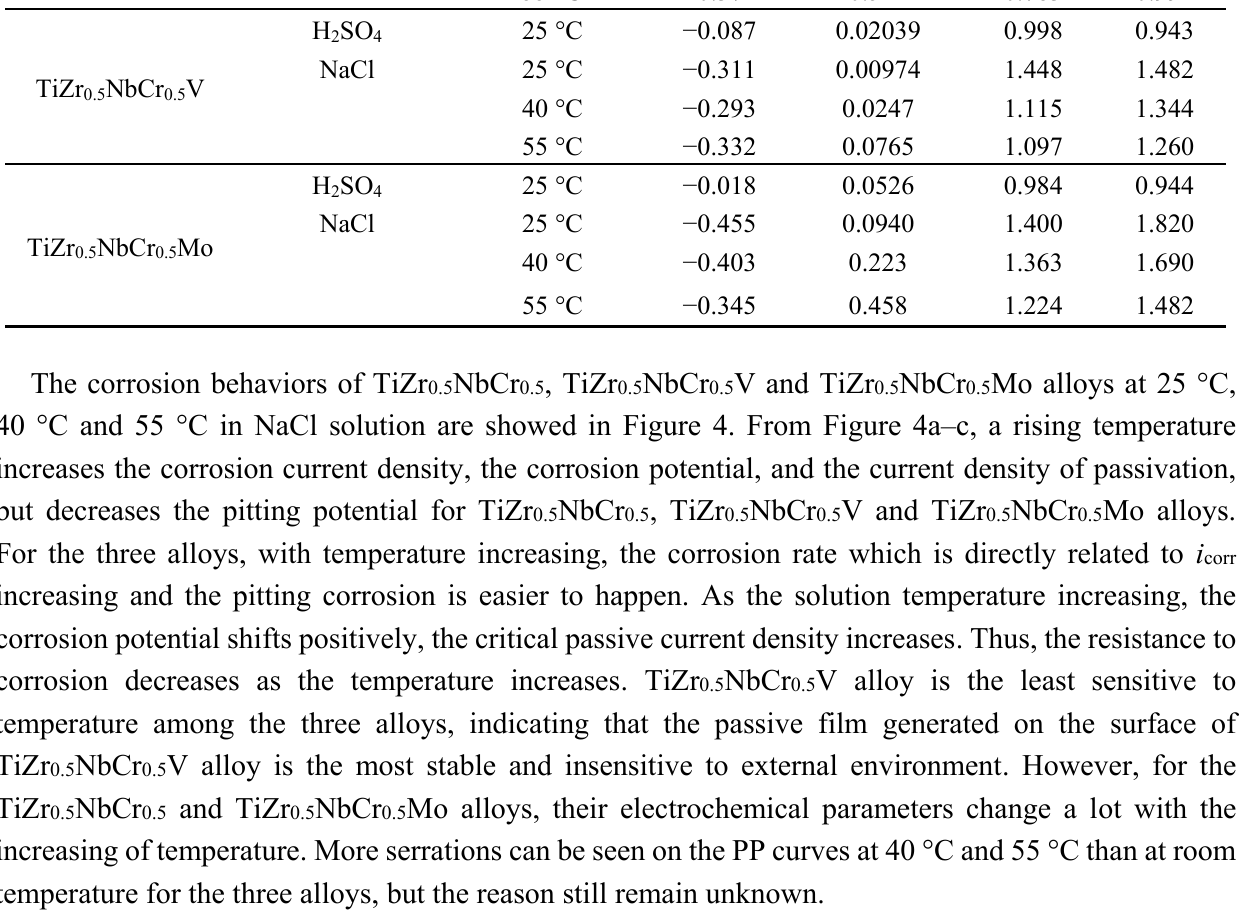
Table 3. Electrochemical parameters of TiZr 0.5 NbCr 0.5 , TiZr 0.5 NbCr 0.5 V and TiZr 0.5 NbCr 0.5 Mo alloys. Alloys Type of solutions Temperature E corr (V SCE ) I corr (μA/cm 2 ) E pit (V SCE ) Δ E (V) H 2 SO 4 TiZr 0.5 NbCr 0.5